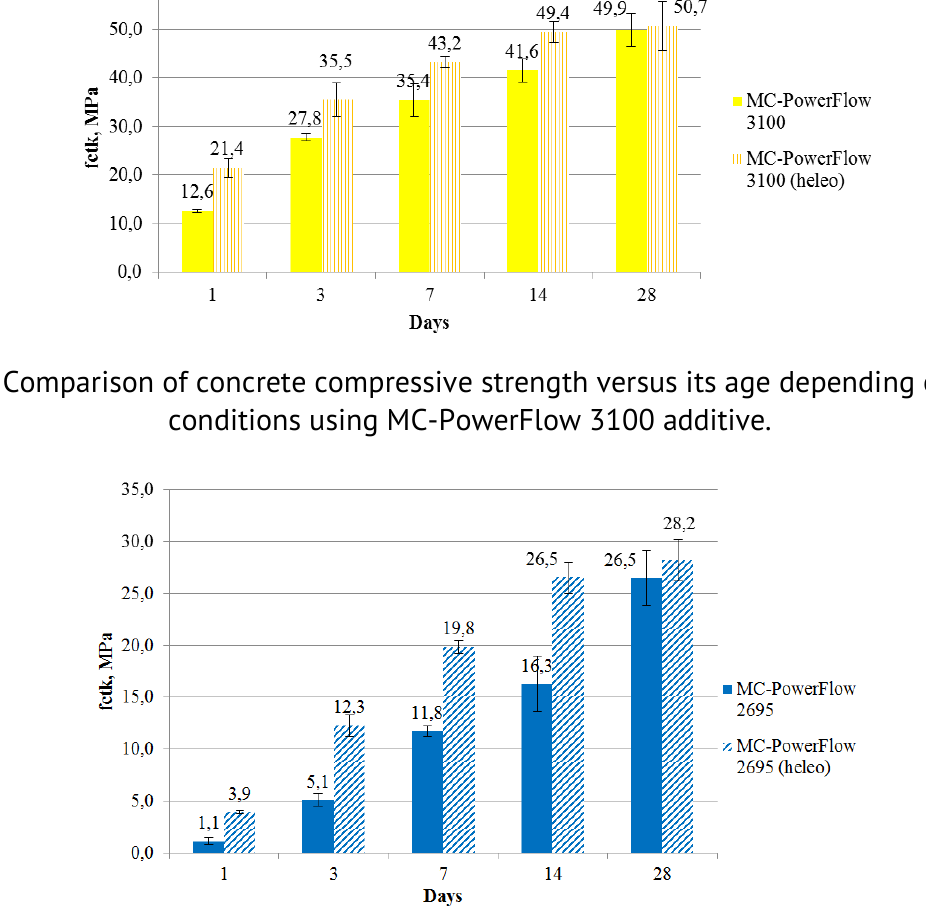
Figure 4. Comparison of concrete compressive strength versus its age depending on storage conditions, using MC-PowerFlow 2695